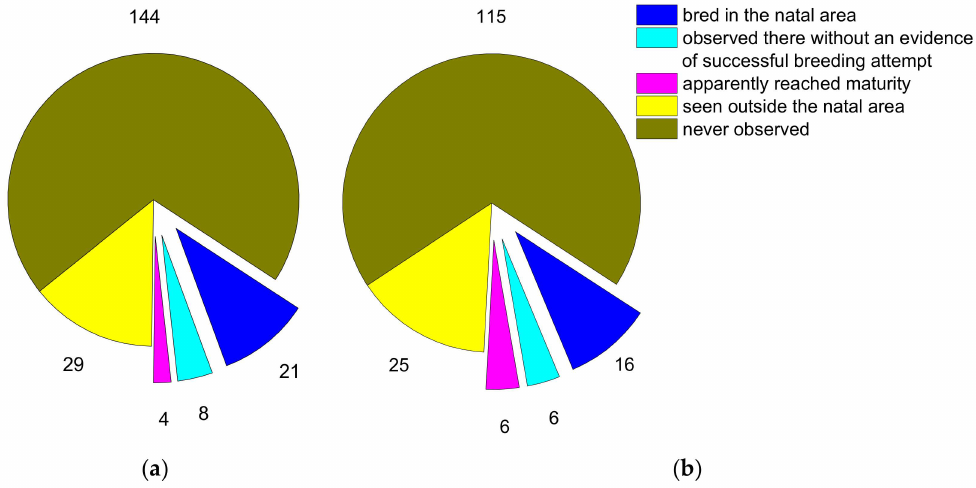
Figure 5. Fate of birds marked in 2012–2020 by the end of 2022 ( a ) HS ( n = 206) and ( b ) wild-reared ( n = 168) chicks based on known